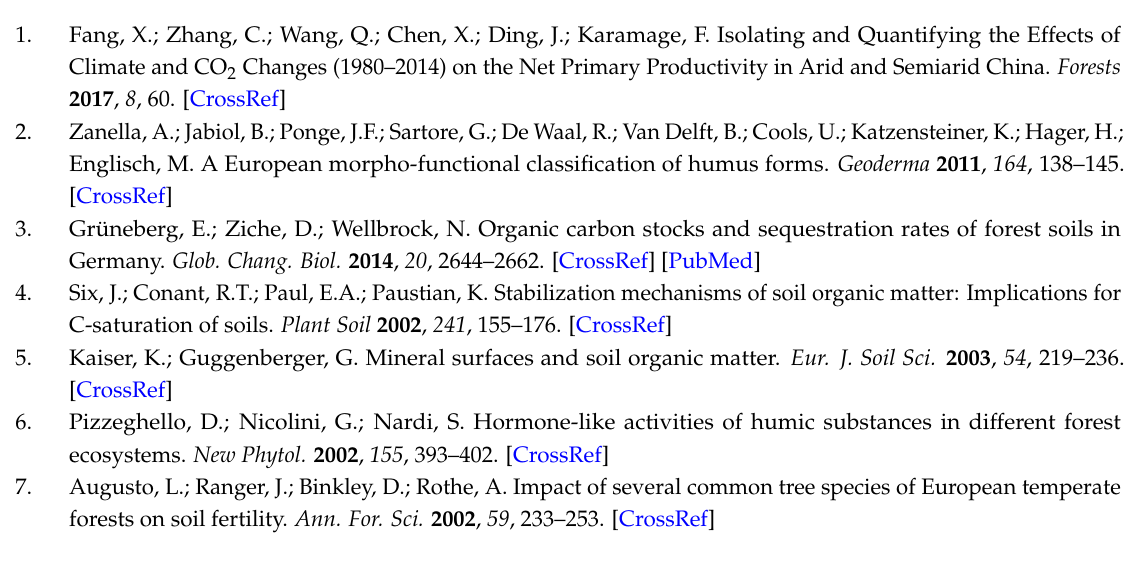
Table S1: Mean values of physical and chemical soil properties under different land use types, Table S2: Mean values of physical and chemical soil properties per